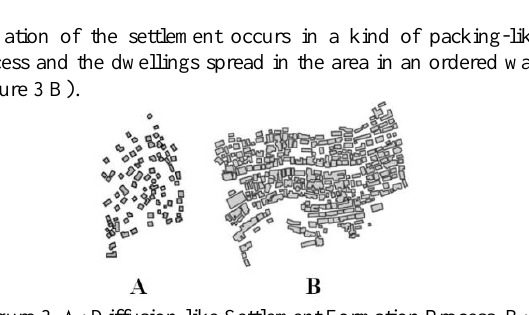
Figure 3. A: Diffusion-like Settlement Formation Process, B: Packing-like Settlement Formation Process (Sobreira & Gomes,